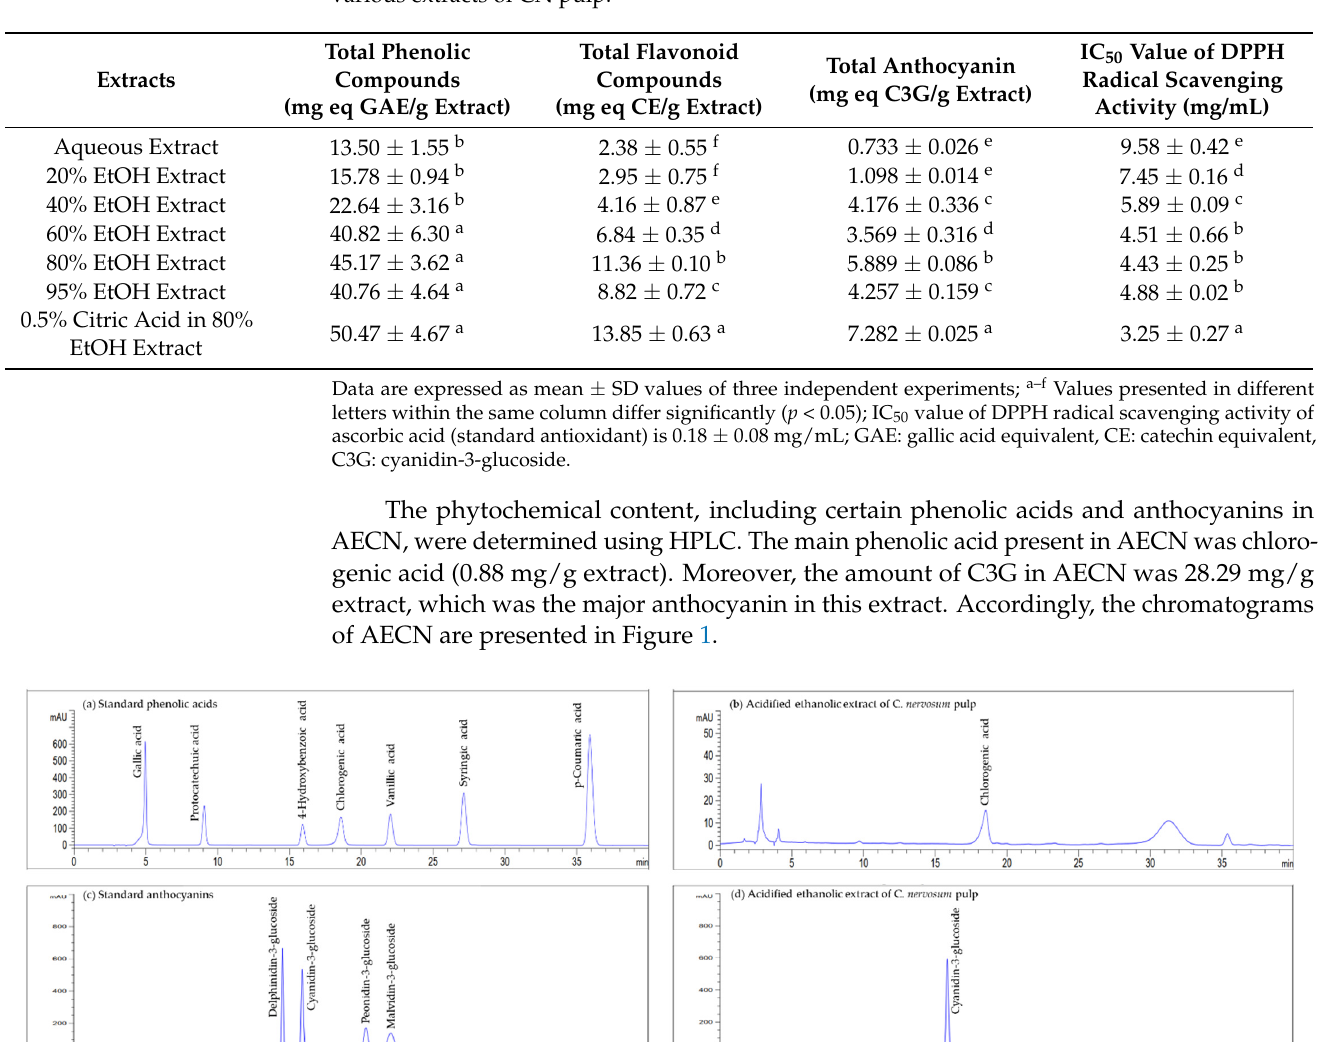
Table 1. Phytochemical constituents and IC 50 values of scavenging activity using DPPH assay in various extracts of CN pulp.